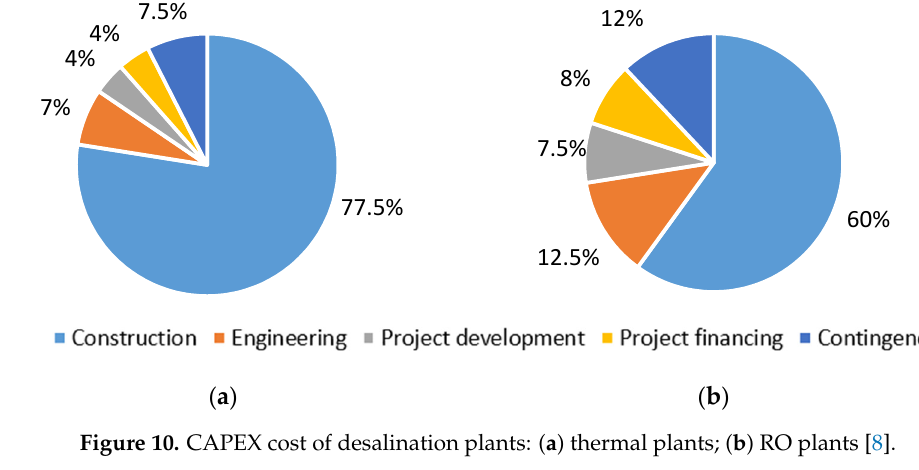
Figure 10. CAPEX cost of desalination plants: ( a ) thermal plants; ( b ) RO plants [8].